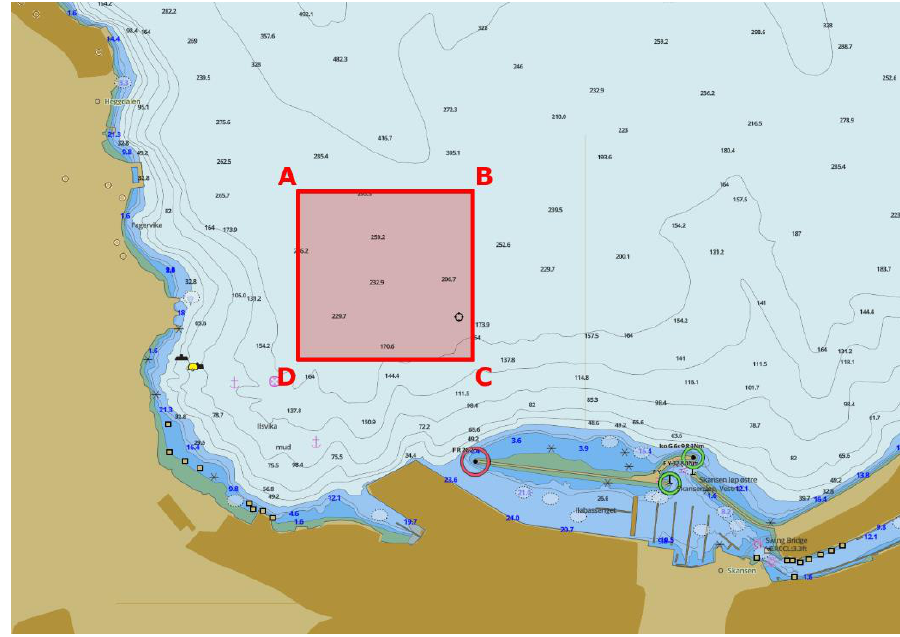
Figure 23. Final SWARMs demo test area used for validation.